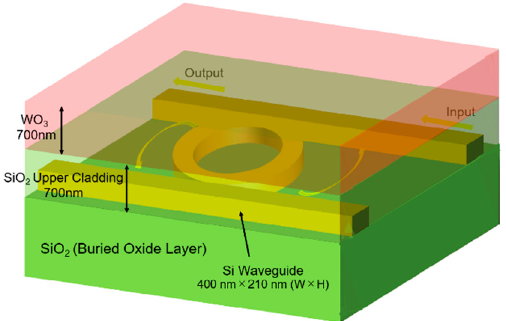
/ Si microring resonator (MRR)-based H